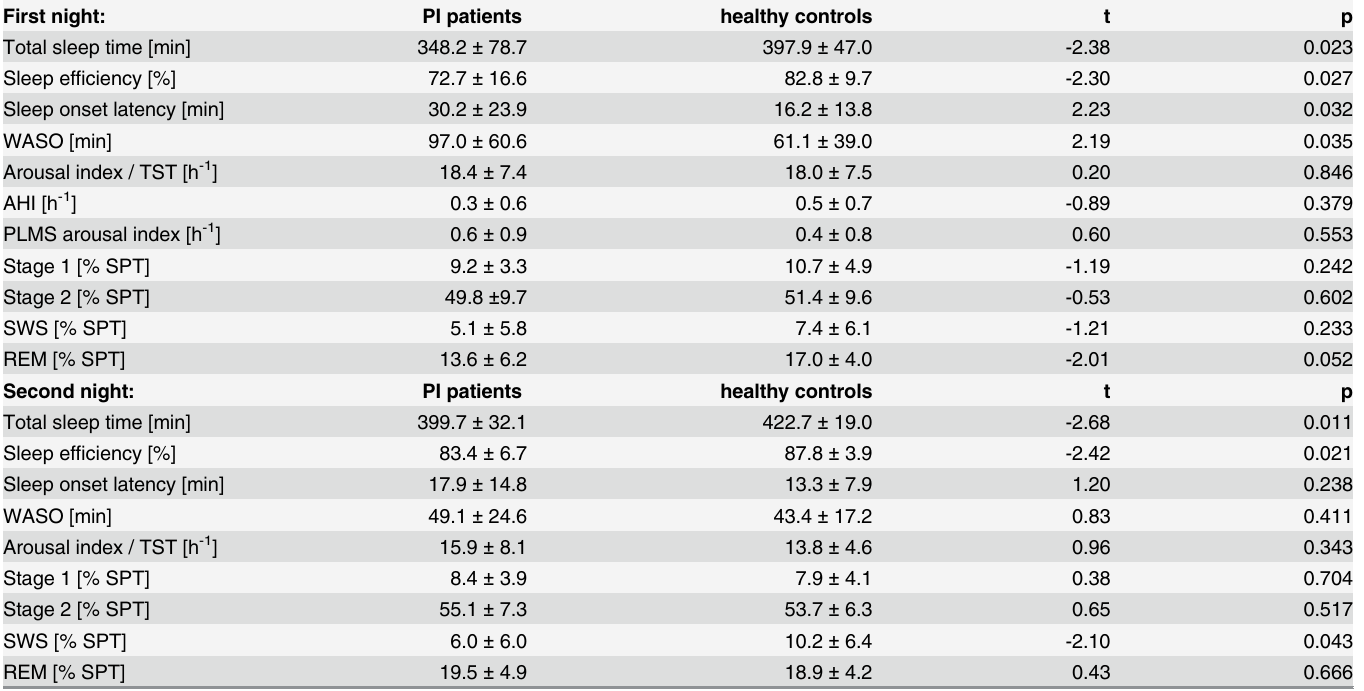
Table 2. Polysomnographic data (means ± standard